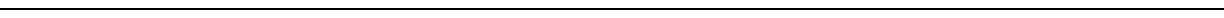
Fig. 4 Biochemical veri fi cation of the (NFS1-ISD11-ACP-ISCU) 2 structure in yeast. a Sequence alignment of ISD11 from S. cerevisiae (Saccer), H. sapiens (Human), and C. thermophilum (Caethom). Mutations are indicated by arrows. Locations of the mutations are indicated in the crystal structure of human ISD11 using the corresponding Saccer nomenclature. b – f Gal-ISD11 yeast cells expressing S. cerevisiae Acp1-HA were transformed with plasmids encoding either no protein (empty) or wild-type (WT) or the indicated FLAG-tagged Isd11 mutant proteins. Gal-ISD11 yeast cells were depleted of endogenous Isd11 on glucose medium for 40 h, and mitochondrial extracts were prepared. b Anti-FLAG co-immunoprecipitation. The immunoprecipitate (Co-IP) and an aliquot of the mitochondrial extract (input) were analyzed by immunostaining for the indicated ISC proteins and porin as a loading control using antibodies against the respective protein or tag (anti-FLAG: Sigma and anti-HA: Santa Cruz). c Blue-native gel electrophoresis (7.5 – 20% polyacrylamide). Immunostaining was against FLAG of Isd11-FLAG. d Cysteine desulfurase activity of 200 µ g mitochondrial extracts following the in vitro sul fi de production. e , f Enzyme activity assays of mitochondrial aconitase e and SDH f normalized to malate dehydrogenase (MDH). g Orbitrap mass spectrometry of trypsin- digested puri fi ed CtNfs1-CtIsd11 solution with and without bound ACP. For quanti fi cation the peak area was used. Black and gray bars represent the samples puri fi ed from cells growing in high or low energy media, respectively. No ACP could be detected in the latter (n.d.). h Desulfurase activity was measured with puri fi ed human or C. thermophilum NFS1-ISD11 with or without co-puri fi ed ACP. The error bars indicate the SD (n ≥ 3). i In vitro enzymatic Fe/S cluster synthesis on ISCU2/CtIsu1 28 using puri fi ed human or C. thermophilum (Ct) ISC proteins. NFS1-ISD11 with or without co-puri fi ed ACP as indicated were mixed anaerobically with ISCU, FXN, FDX2, and FdxR, and Fe/S cluster synthesis on ISCU2 was followed by circular dichroism monitoring Δ CD at 431 nm (left). After 20 min CD spectra were recorded to document successful reconstitution of ISCU2 (right). Control reactions were performed without